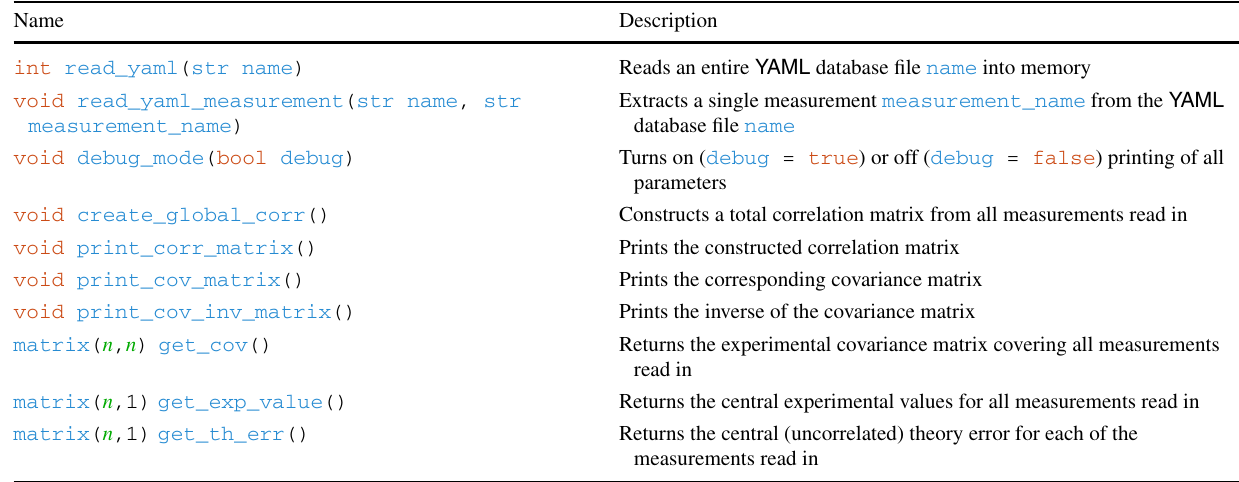
Table 7 Important methods of the FlavBit Flav_reader class. Here str is an alias for std::string , n is the number of measurements so far read in by the Flav_reader instance, and matrix( x , y ) is an x × y